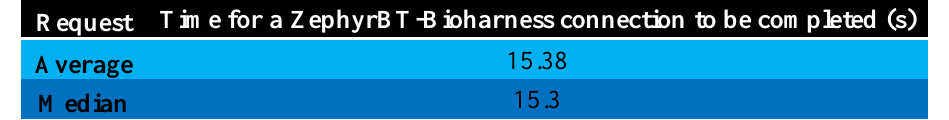
Table 9. Most significant measures obtained to establish a ZephyrBT node-Bioharness